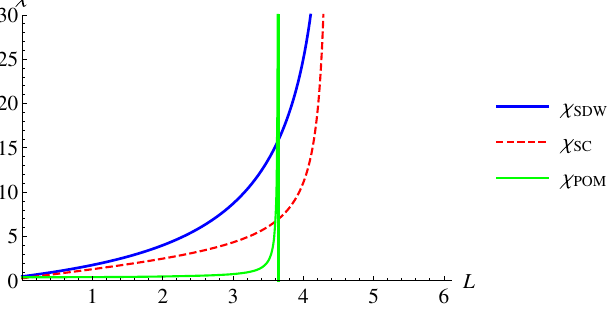
FIG. 6. The flow of the susceptibilities for attactive bare interaction in the orbital channel. We used J ¼ 0 . 02 , U ¼ ð 6 . 1 Þ J , U 0 ¼ U − 2 J , J 0 ¼ J . For these parameters, the bare interaction in the B 1 Pomeranchuk channel is attractive [it is 2 U 0 − ð U þ J Þ , Ref. [9]]. We see that the flow of the susceptibilities is very similar to the case when the bare B 1 interaction is repulsive, but the Pomeranchuk susceptibility diverges at a smaller L .